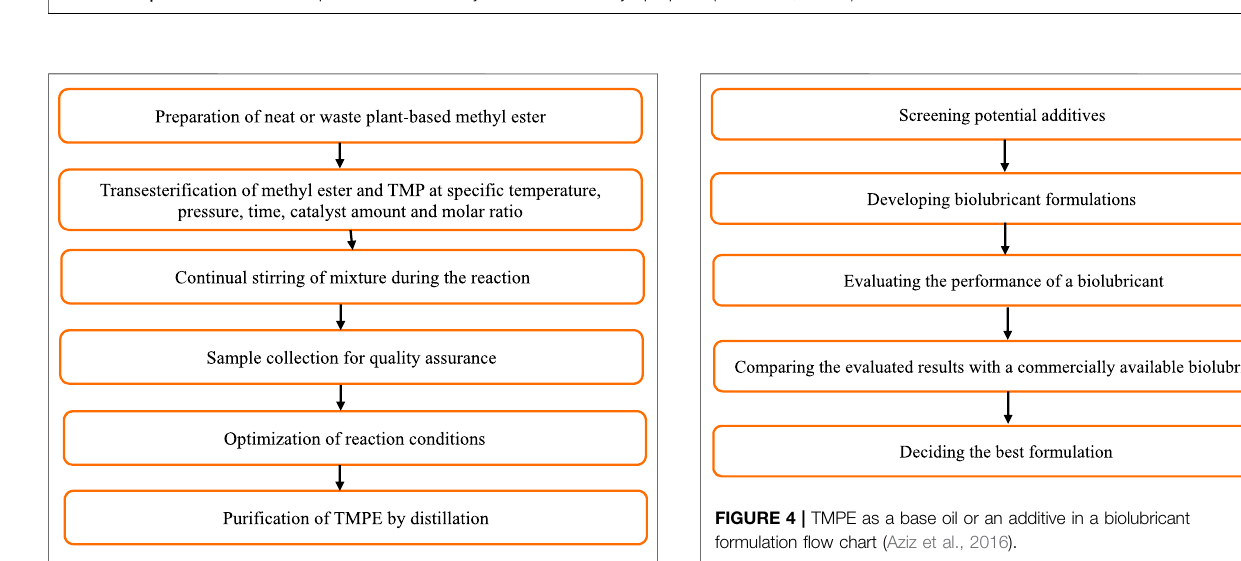
FIGURE 3 | TMPE production via transesteri fi cation reaction fl ow chart (Zulki fl i et al., 2013).